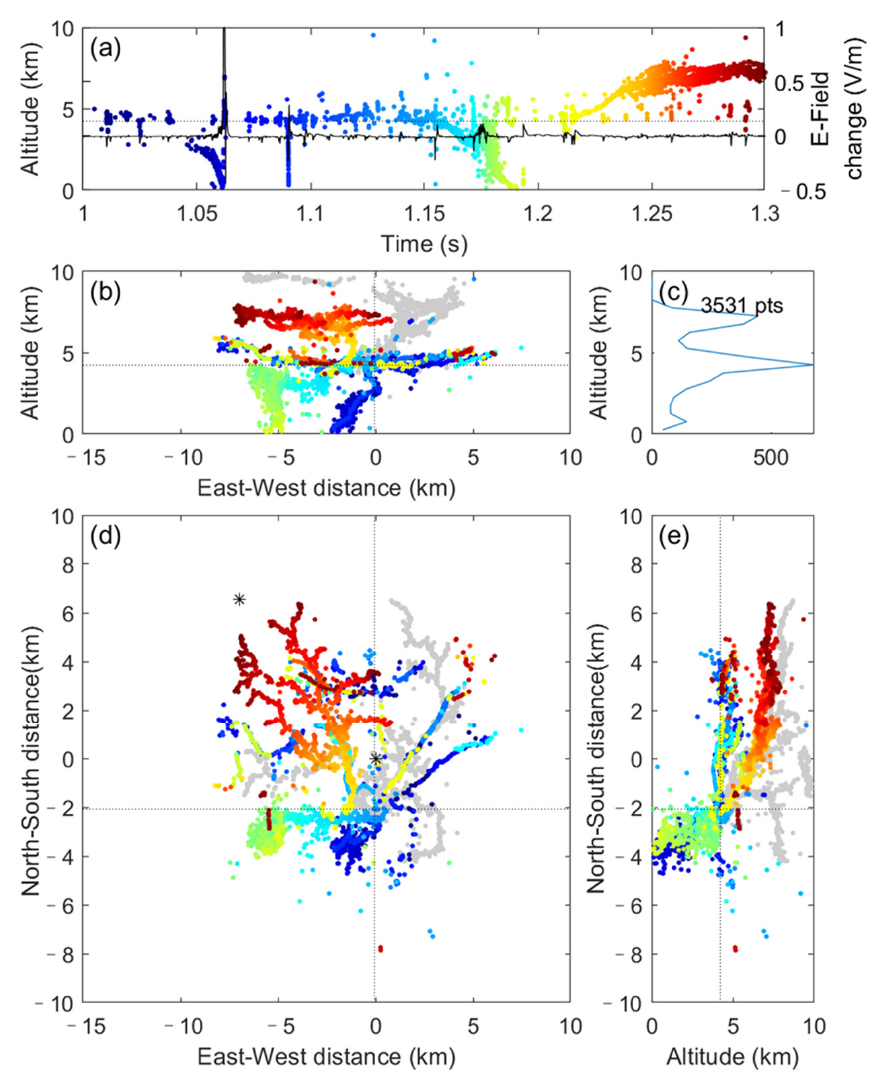
Figure 10. Three-dimensional location results of the leader-return stroke sequences of the CG flash in Figure 8. ( a ) height with time, ( b ) north–south vertical projection, ( c ) height distribution of the number of radiation sources, ( d ) plane projection, and ( e ) east–west vertical projection of the three- dimensional location result. Asterisks are positions of the interferometer. Dashed lines intersect at the initiation point of the flash.